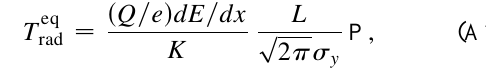
Beam FIG. 11. Beam passes through a wire scanner magnetic field (Fig. 10) from a point charge is still given by Eq. (3). And the maximum surface magnetic field of a beam, Eq. (23), also applies, as do all the other equations. It is notable that the heating is independent of the angle u . Taking a tungsten ( r C (cid:1) 2.58 J (cid:3) cm 3 and dE (cid:3) dx (cid:1) 22.7 MeV (cid:3) cm) wire scanner at the LCLS as an example (Fig. 11), the pulsed temperature rises due to image cur- rents and radiation are T max 1 respectively. And these are on top of an equilibrium tem- perature of